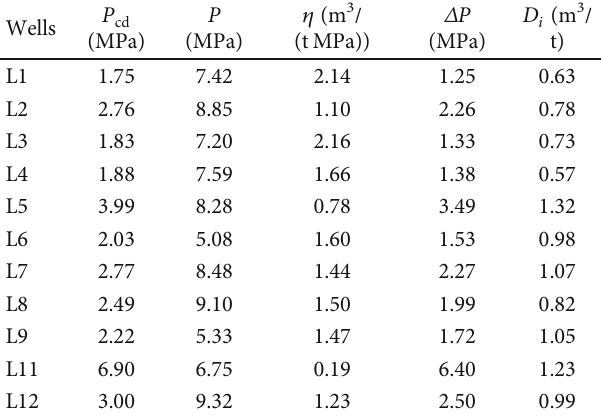
Table 2: Critical desorption pressure, reservoir pressure, desorption e ffi ciency desorption-abandonment di ff erence, and desorption index of No. ( 8 + 9 ) coal seam in Yangjiapo